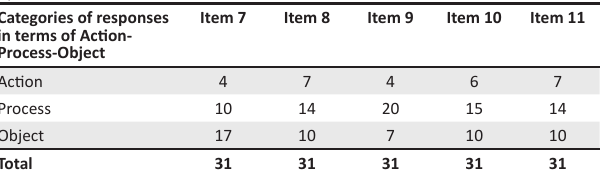
TABLE 5: Students’ development process of using manipulatives in number operations in semester 2. Categories of responses in terms of Action- Process-Object